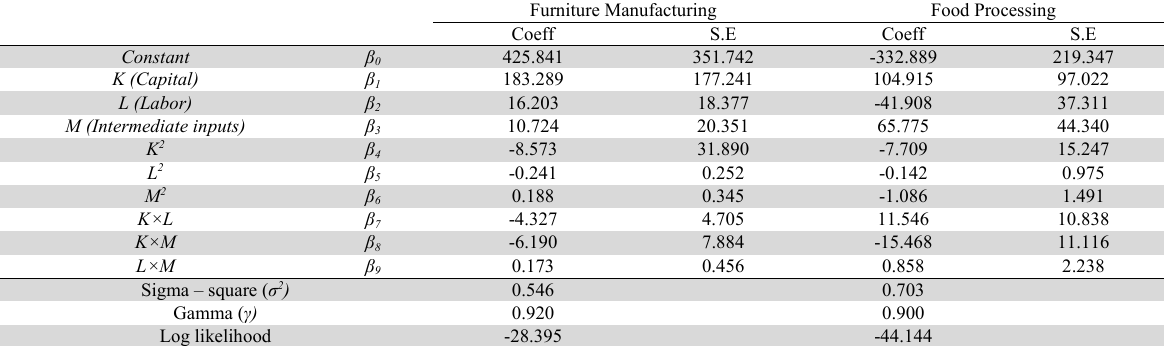
Estimated Frontier Production